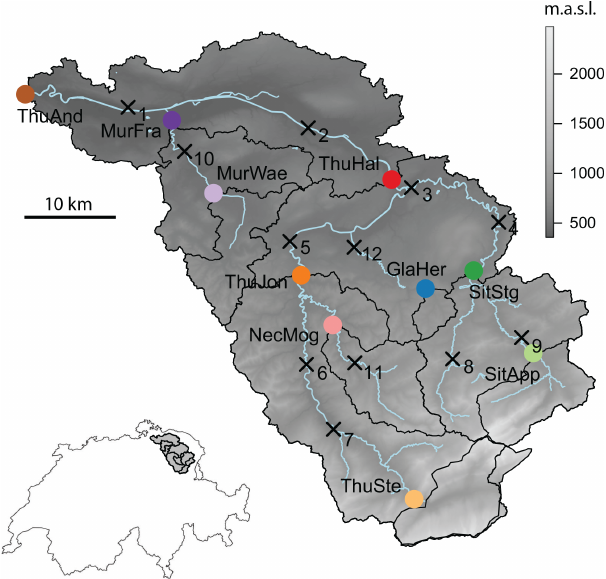
Figure 1. Gauging stations within the Thur catchment in northeast- ern Switzerland (colored dots) and stations used for spatial interpo- lation